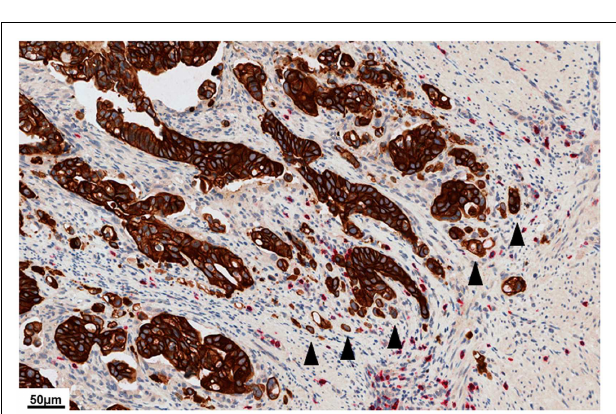
FIGURE 2 | (A) Low power image (5 × ) of a H&E slide and pan-cytokeratin (brown)/CD8 (red) double stain demonstrating a primary CRC with a pushing tumor border configuration of growth.The tumor border is round and well-recognizable at low magnification.Tumor and host tissue can be easily